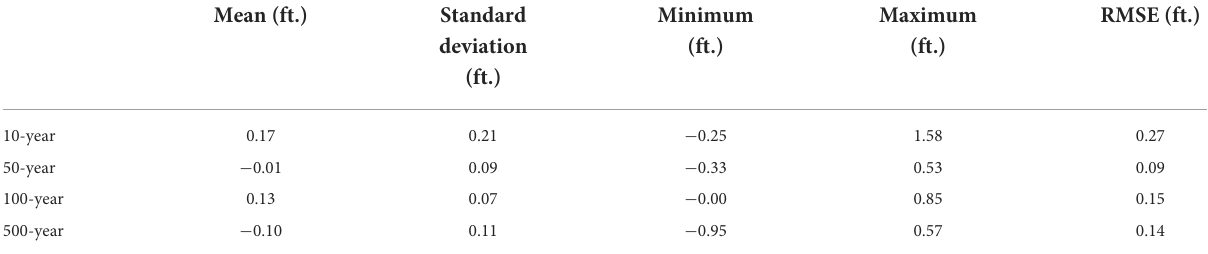
TABLE 5 Descriptive statistics and root-mean-square error for Risk MAP-modeled minus predicted D , for cells having two or more originally-modeled D from among 10-, 50-, 100-, and 500-year return periods, for Metairie, Louisiana, study area. Mean (ft.) Standard Minimum Maximum RMSE deviation (ft.) (ft.) (ft.)